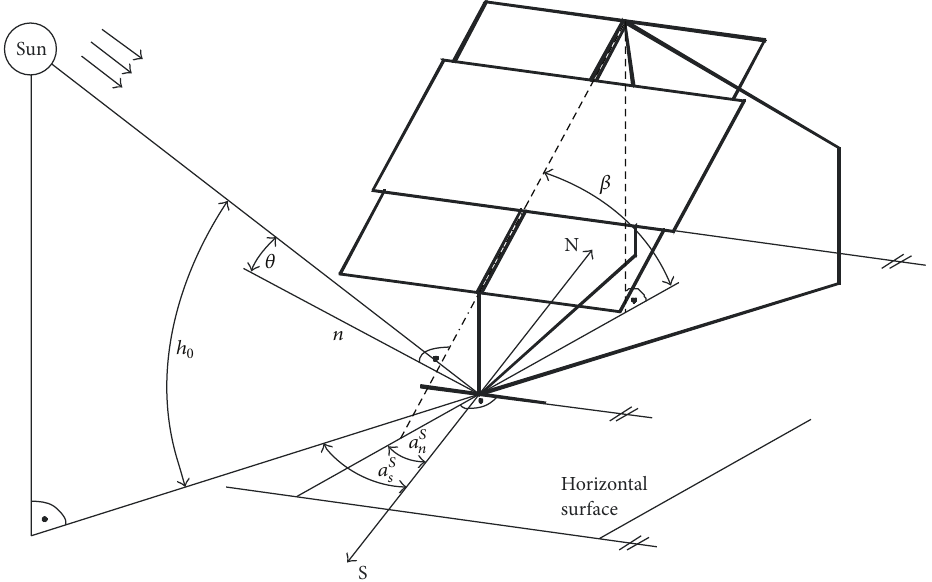
—azimuth of the normal from the south, and n